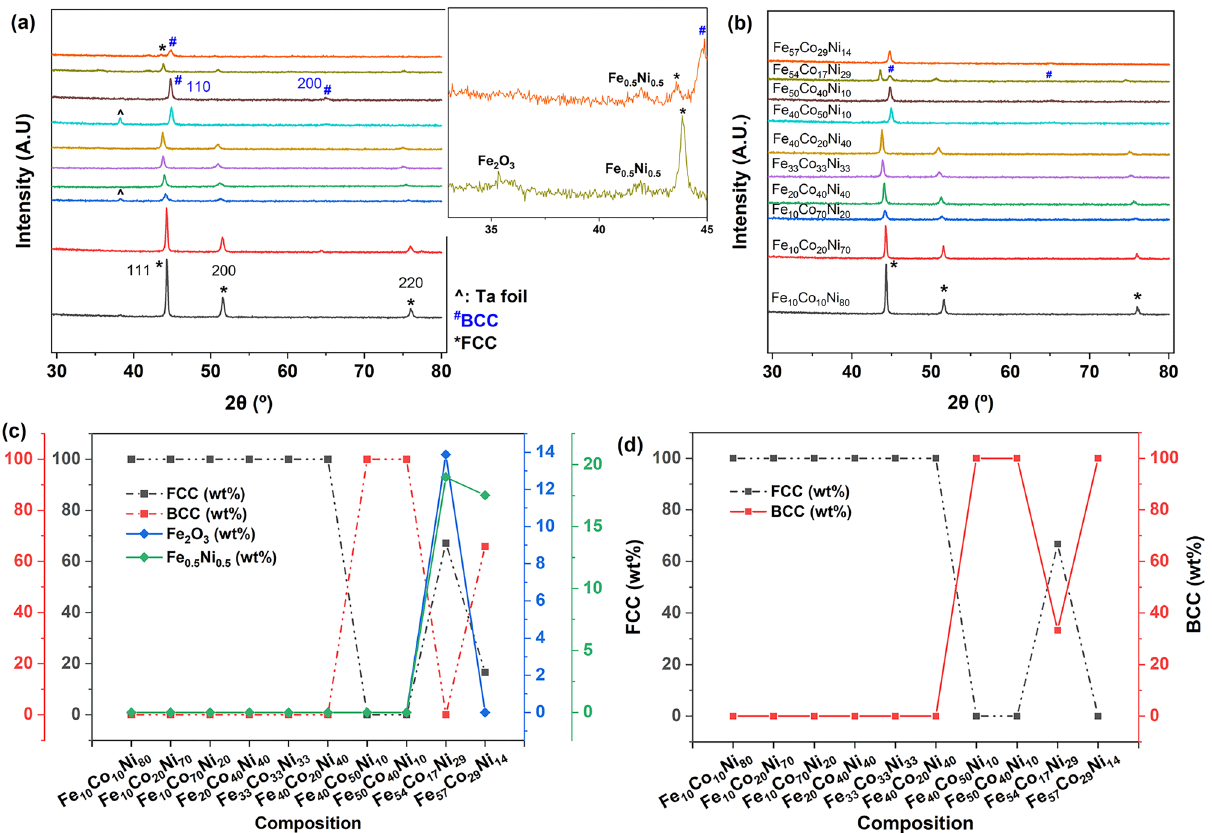
Figure 3. X-ray diffraction patterns of Fe–Co–Ni ternary alloys: ( a ) as-SPS, with the inset showing minority phases, ( b ) annealed at 1000 °C for 2 h in 95% Ar + 5% H 2 atmosphere. Phase fractions in wt% of ( c ) as-SPS